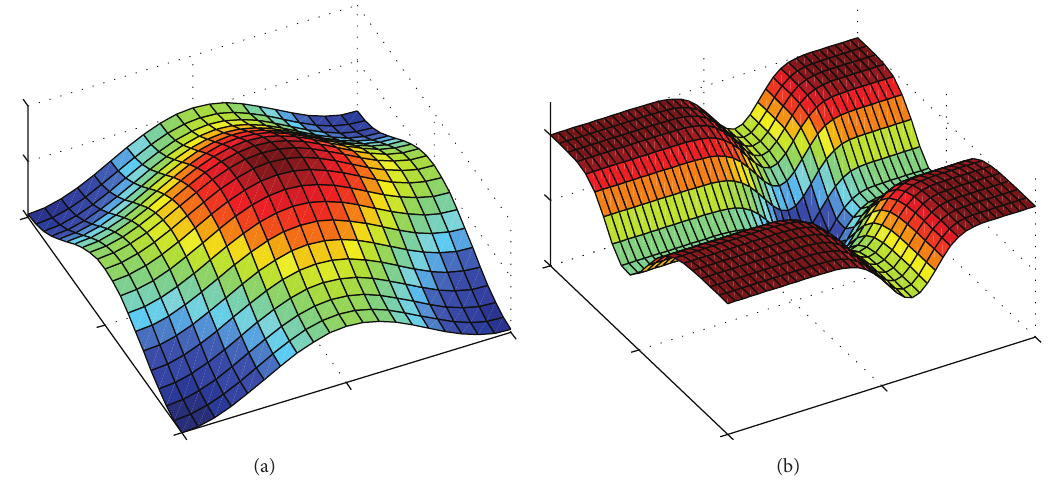
Figure 2: Rastrigin (a) and Michalewicz (b) benchmark